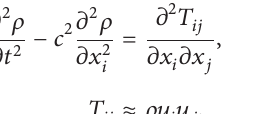
/ 𝜕𝑥 𝑖 𝜕𝑥 𝑗 /( 𝜌 ∞ 𝑈 ∞2 /𝐿 2 ), around cavity for ij